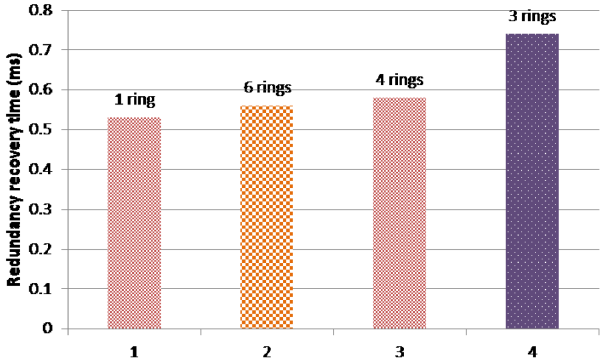
Figure 19. Maximum recovery time of AeroRing under various